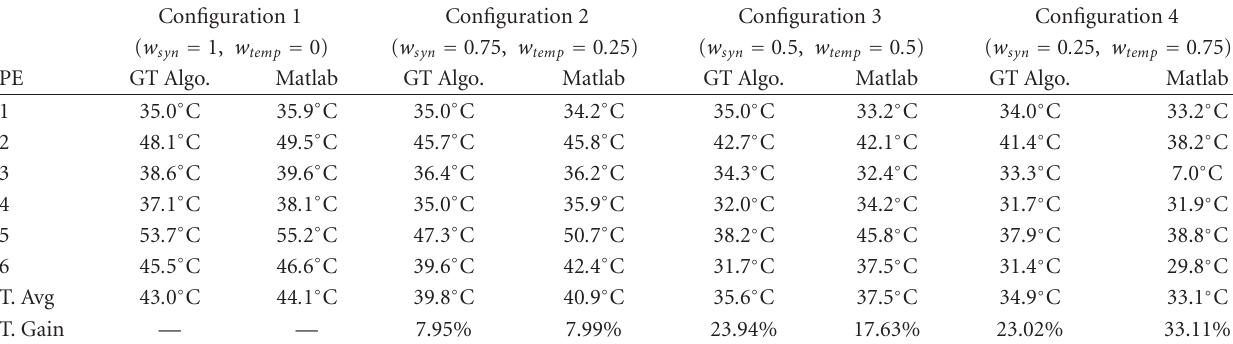
Table 3: Test case temperature profiles.